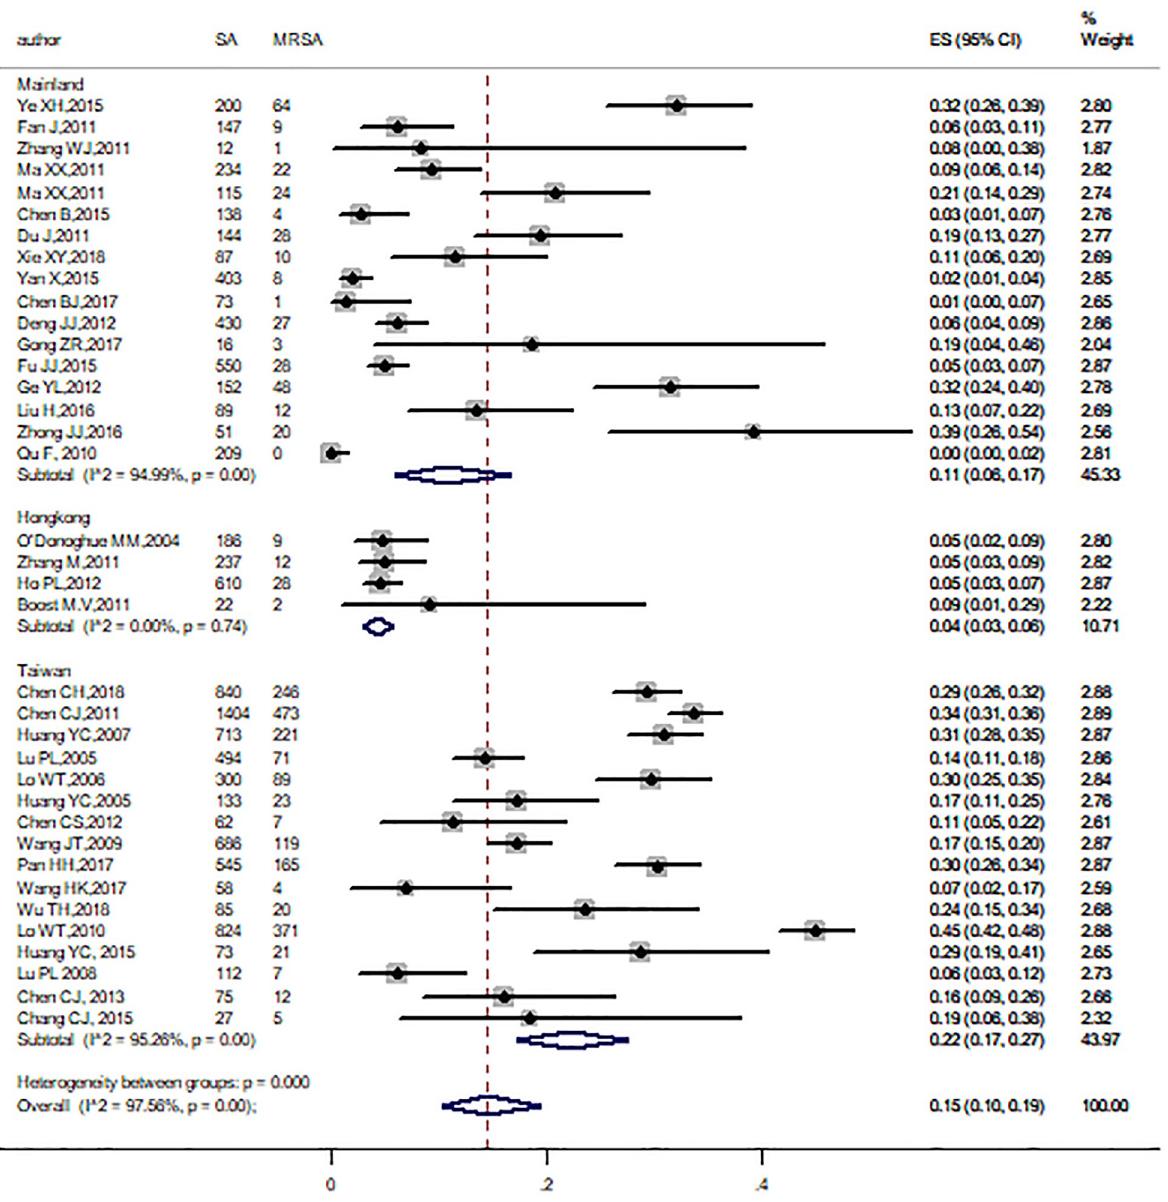
Fig 7. Subgroup analysis for the prevalence of MRSA by